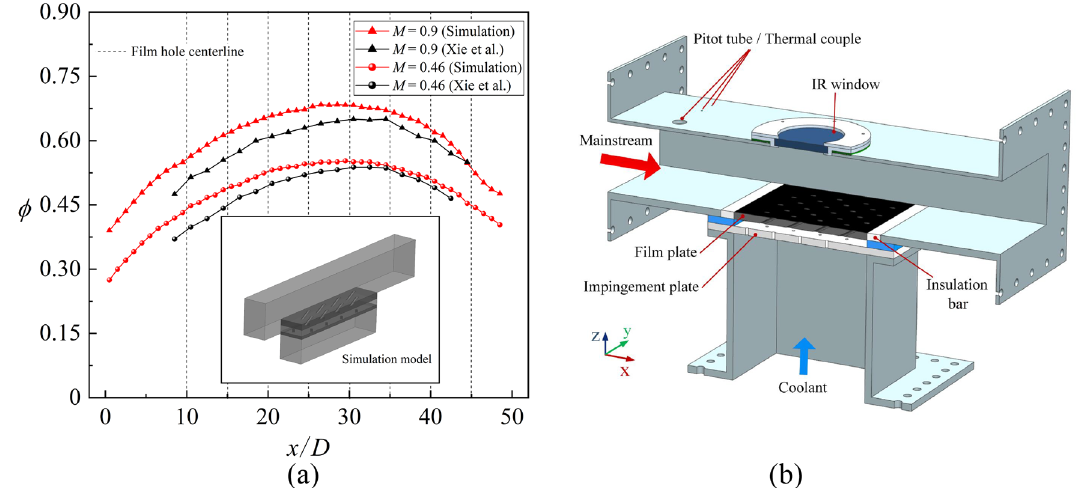
Figure 10. Comparison between numerical simulation and experimental results 28 . ( a ) Laterally averaged overall cooling effectiveness; ( b ) Schematic view of test Section 28